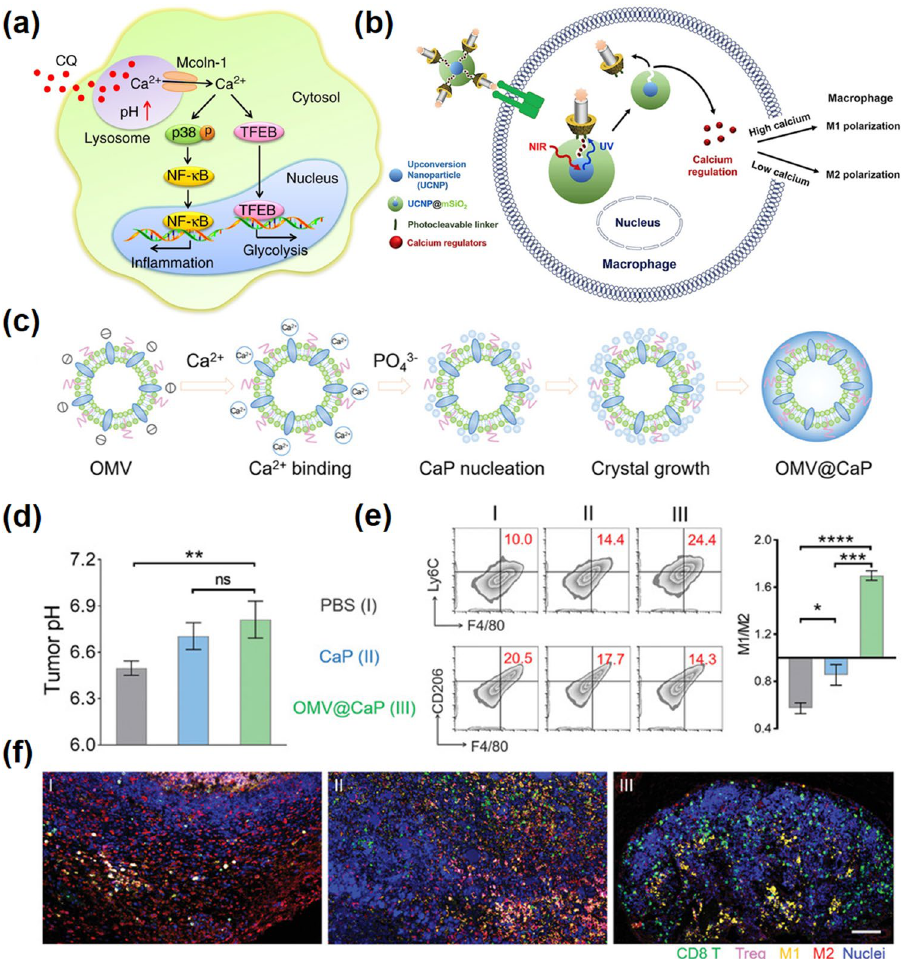
Fig. 12 Ca-NMs promote polarization of macrophages. a Schematic illustration of chloroquine (CQ) resetting tumor-associated macrophages (TAMs) [183]. Copyright 2018, Springer Nature. b Illustration of the synthesis process of nanomaterials and experimental scheme used in this study [148]. Copyright 2018, Elsevier. c Scheme diagram of biomineralization procedure of OMV@CaPs. d Multispectral fluorescence quanti- fication pH value of tumor tissues in different treatment groups. e Flow cytometry analysis of M1 macrophages and M2 macrophages, and M1/ M2 ratio (right panel) in tumors. f Images of tumor tissue stained with Opal multicolor immunofluorescence [41]. Copyright 2020,